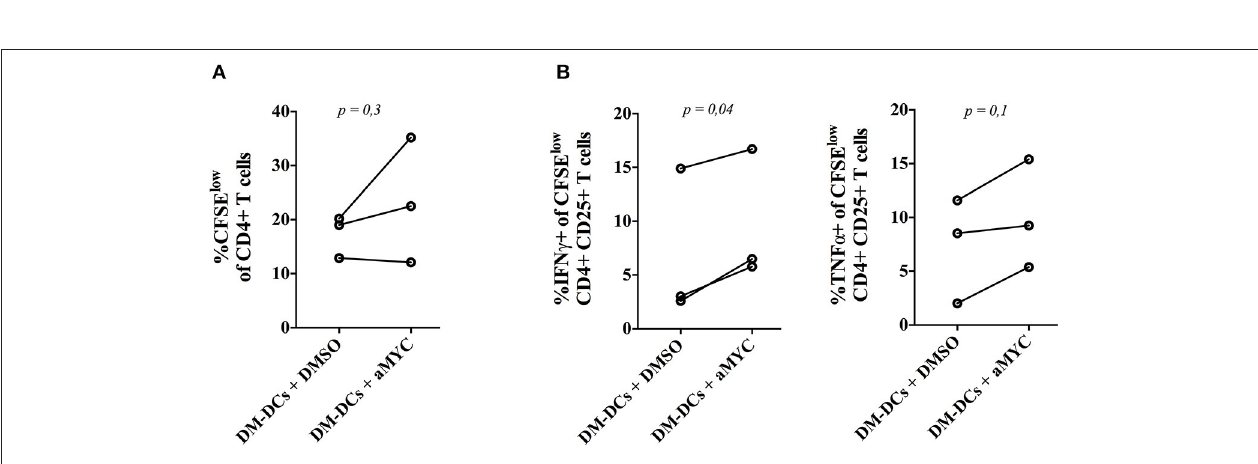
FIGURE 3 | protein level. (A) Flow cytometry analysis of molecules involved in immune response. Shown are MFI values of 5 independent experiments ( n = 5). (B) Gene expression of tolerance-related genes was assessed through real time PCR. Shown are fold expression values of Dex-modulated and MPLA-activated dendritic cells (DM-DCs) with or without 10058-F4 calculated relative to untreated/immature DCs (DCs) expression. M-DCs and DMSO-cultured DM-DCs were used as controls ( n = 3) (* p = 0.05, ** p = 0.01). DM-DCs, Dex-modulated MPLA-activated DCs + ; M-DCs, MPLA-matured DCs.